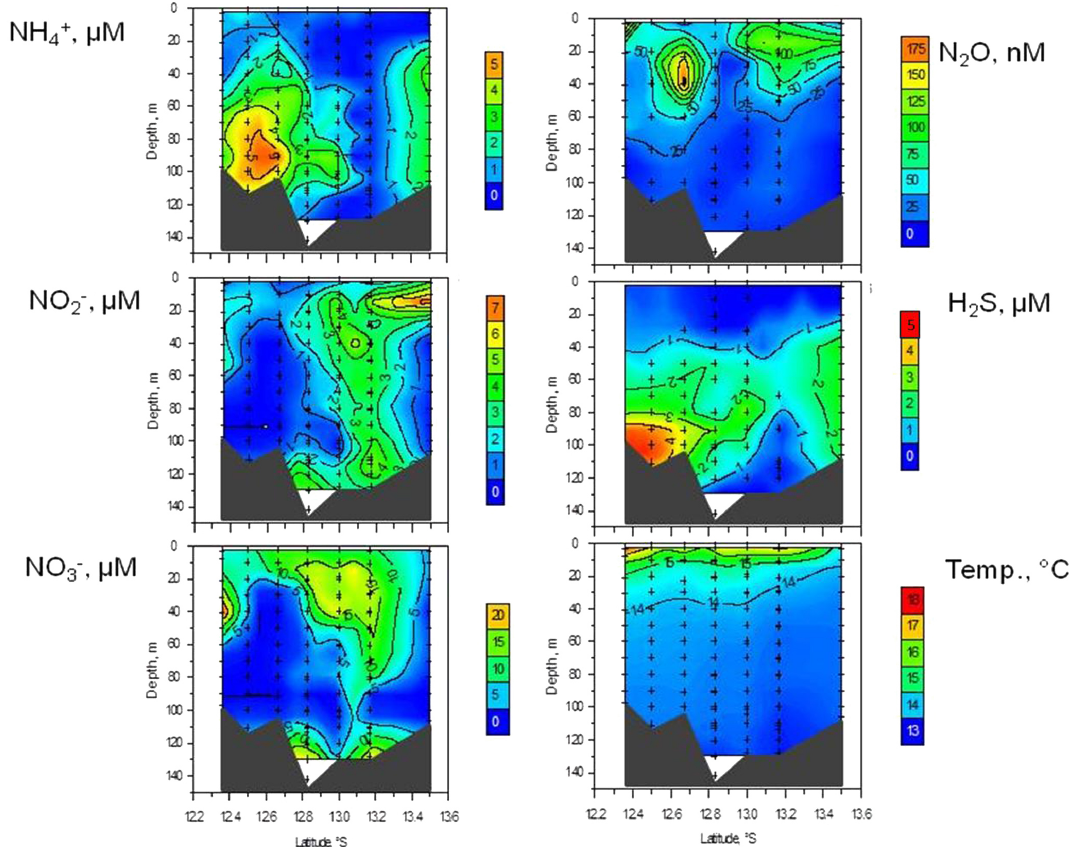
Figure 6. Distributions of N 2 O, NH − , NO − , NO − , H 2 S, and water temperature during December 2008/January 2009 (R/V Meteor cruise 4 2 3 M77/3) on the shelf along the coast of Peru. Max N 2 O concentrations have been detected right above the sulfidic zone, where a sharp oxycline is present and ammonium and nitrate are